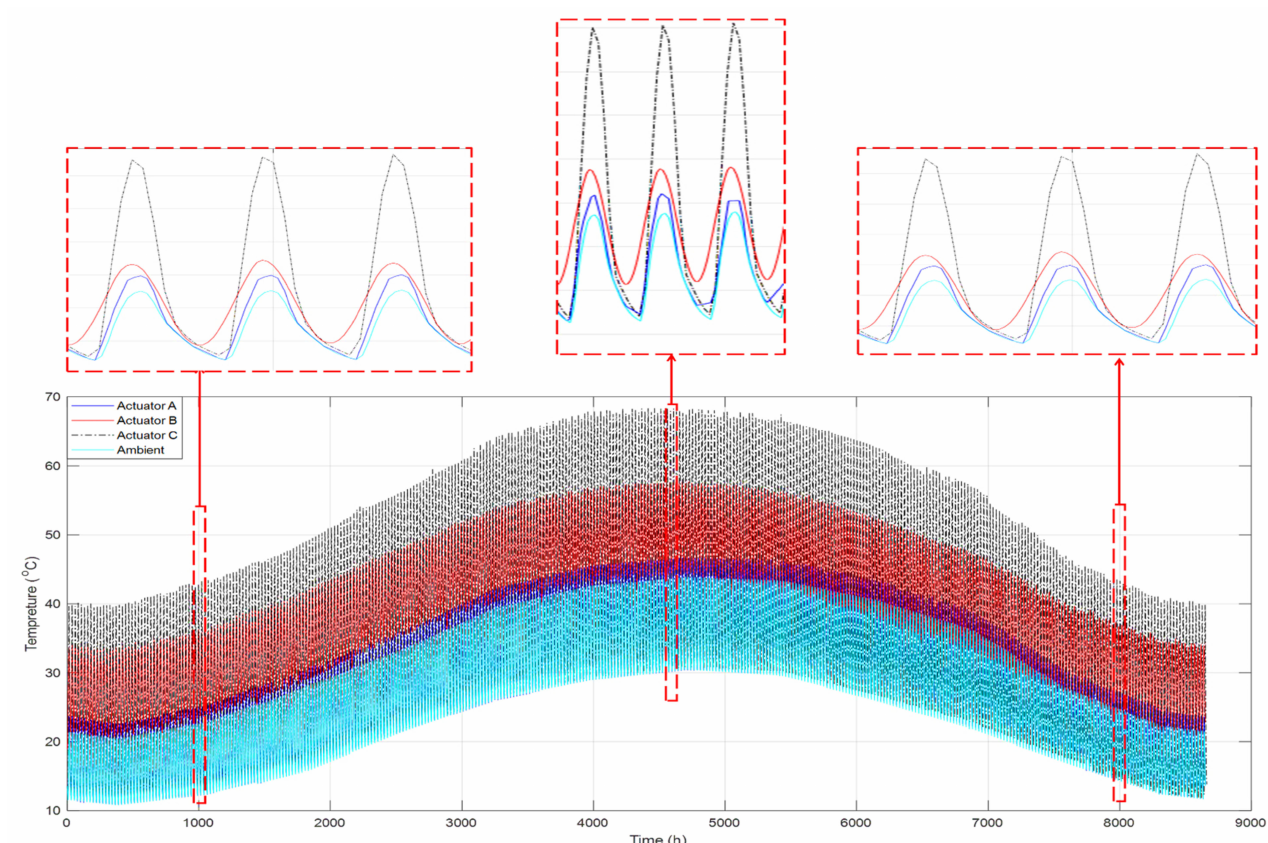
Figure 12. Temperature profiles inside the SHC over an entire year.